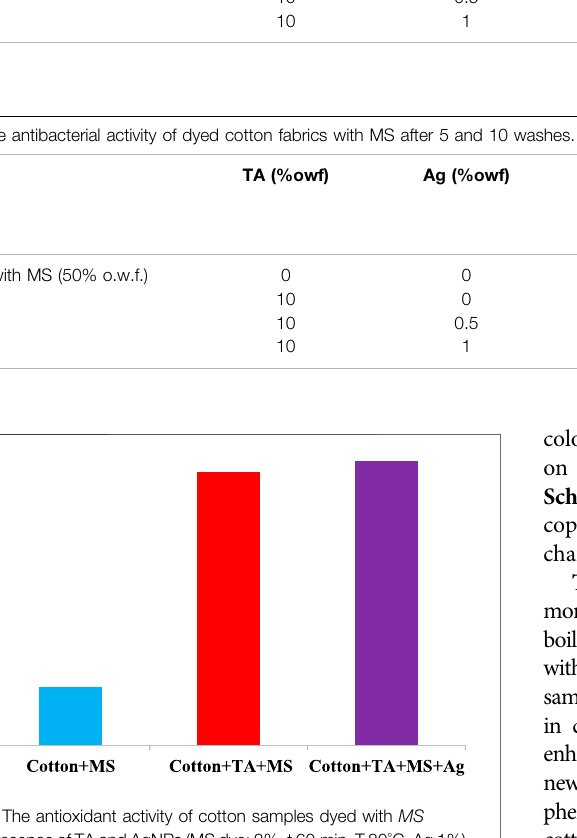
Raw cotton — — — Cotton dyed with MS (50 %o.w.f.)